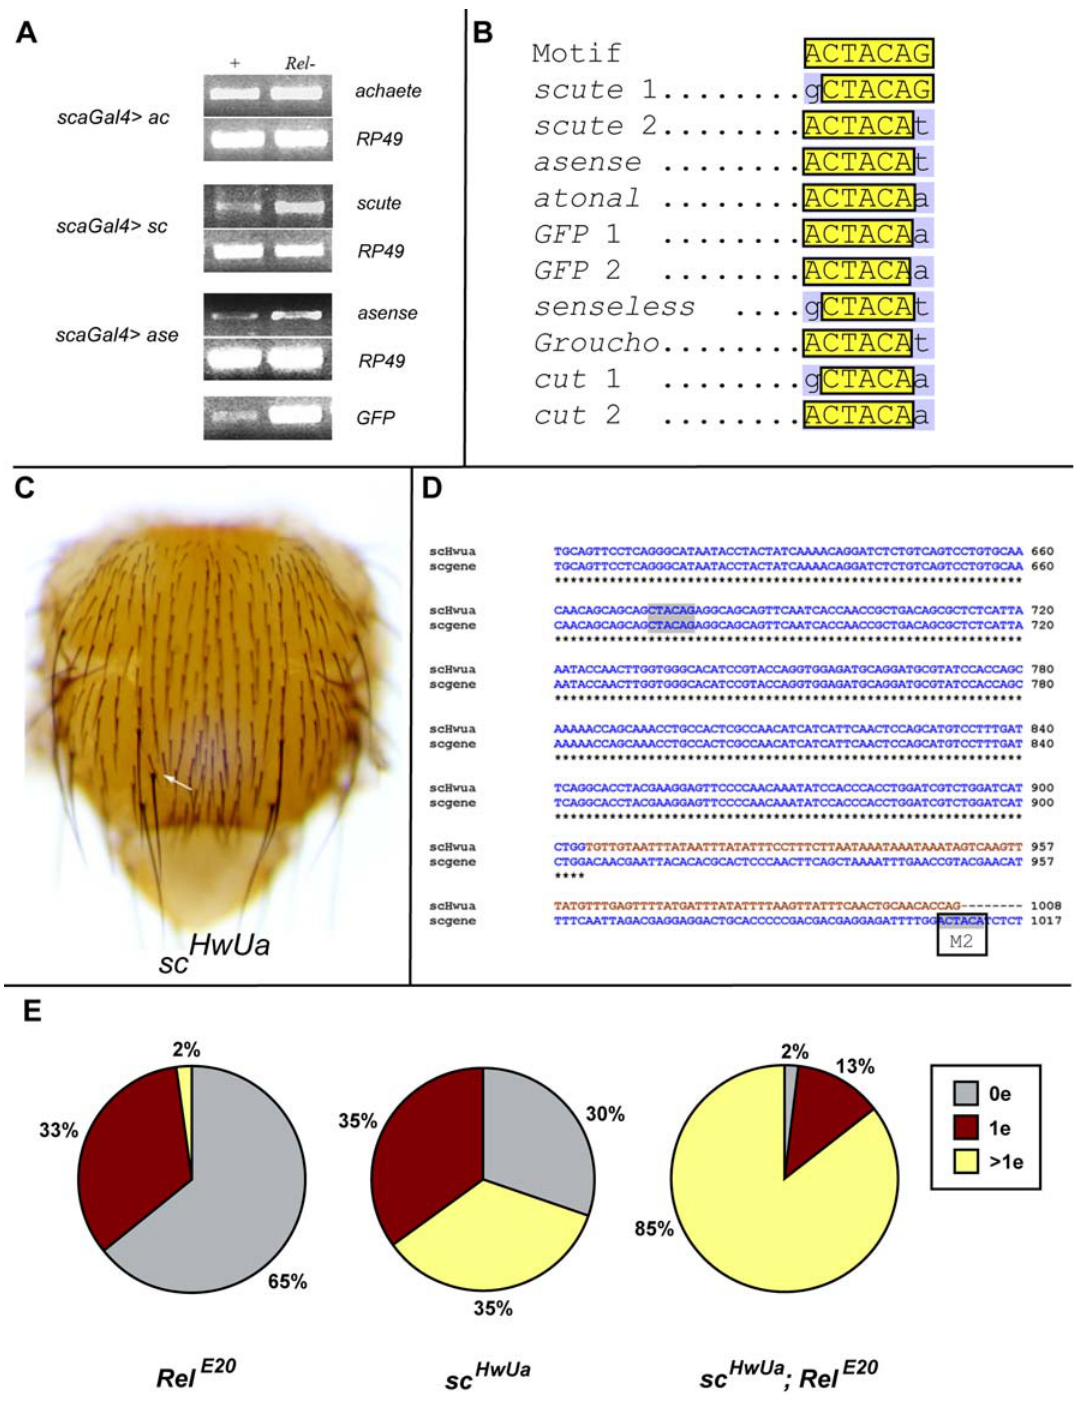
Figure 6. Transcript stability in Relishmutants correlates with the presence of a heptamer sequence in the coding regions of target genes. (A), levels of heterologous (UAS) achaete, scute, asense and GFP transcripts driven by sca -Gal4 in wild-type (left column) and Rel E20 (right column) flies. The ribosomal RNA RP49 was used as a loading control. Levels of scute and asense but not ac transcripts are elevated in the mutant. In addition levels of GFP transcript are elevated. (B), a sequence motif similar to that described in Sox9 and MyoD (ACTAGA) is present in scute, asense, senseless and a number of other genes involved in patterning the notum. The central five core element nucleotides, CTACA, are conserved in all cases. The 3 9 -most nucleotide, G, is replaced in most cases by a T or an A. The 5 9 -most nucleotide, A, is replaced by a G in three cases (shown in grey). The final base, G, is mostly substituted by A or T. (C), the sequence of scHw Ua is presented. Transcription stops within the copia element whose sequence is given in red. The two MyoD motifs are outlined in grey; one, M2, is predicted to be absent from the truncated transcript. (D), a photograph of a scHw Ua mutant fly showing the presence of an ectopic dorsocentral bristle (white arrow). (E), pie charts representing the percentage of heminota displaying ectopic bristles from a total of 200. Red sectors indicate the percentage with one ectopic macrochaete, yellow sectors two or more ectopic macrochaetes (p . 0.001 when compared with wild type).